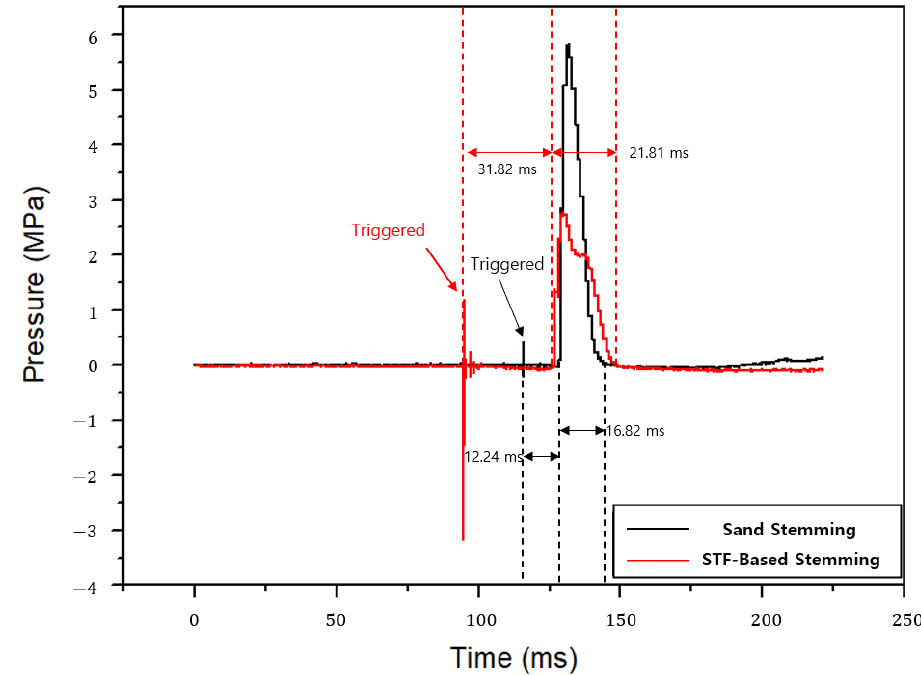
Figure 9. Time ‐ pressure hysteresis curve inside the blast hole. Figure 9. Time-pressure hysteresis curve inside the blast